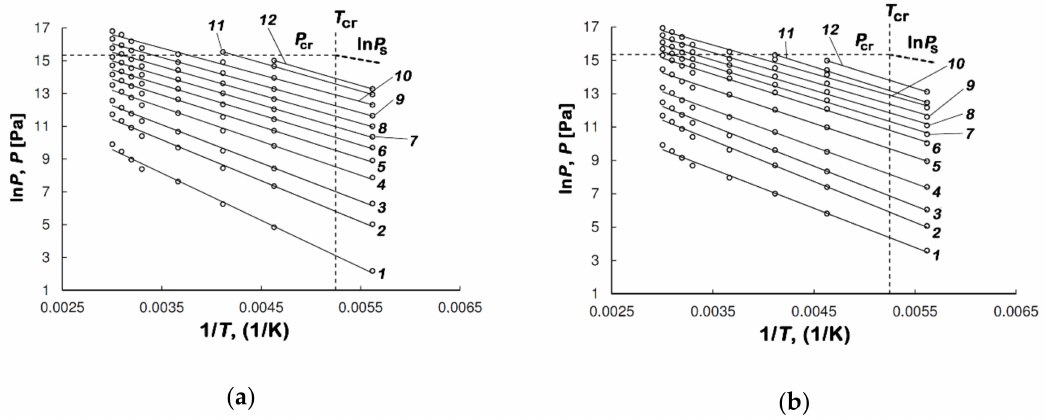
Figure 5. The isosters of methane adsorption in AC-4 ( a ) and AC-6 ( b ) at the values of methane adsorption, mmol / g: 0.1 ( 1 ); 0.5 ( 2 ); 1.0 ( 3 ); 2.0 ( 4 ); 3.0 ( 5 ); 4.0 ( 6 ); 5.0 ( 7 ); 6.0 ( 8 ); 7.0 ( 9 ); 8.0 ( 10 ); 9.0 ( 11 ); 9.5 ( 12 ). Symbols mark the experimental data, and the solid straight lines show the linear function approximation. The bold dashed line shows ln P s , where P s is the saturated vapor pressure; the dashed lines show the critical pressure and temperature of